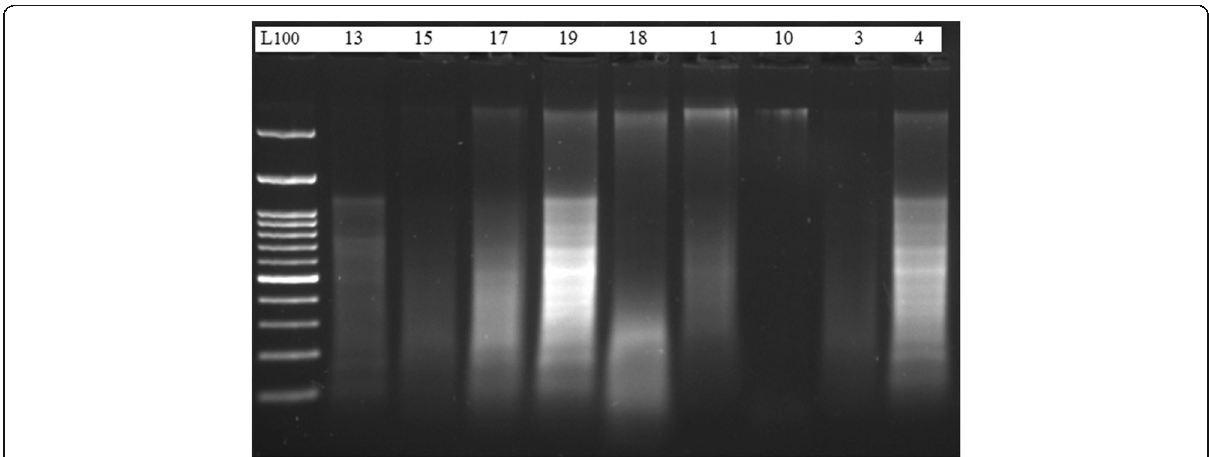
Fig. 3 DNA digested with HindIII enzyme. DNA samples extracted by the standardized method and digested with HindIII enzyme. Digested products were separated in 1.5% agarose gel stained with ethidium bromide, in 1×TAE buffer. The digested products were visualized by UV fluorescence. M is a molecular marker